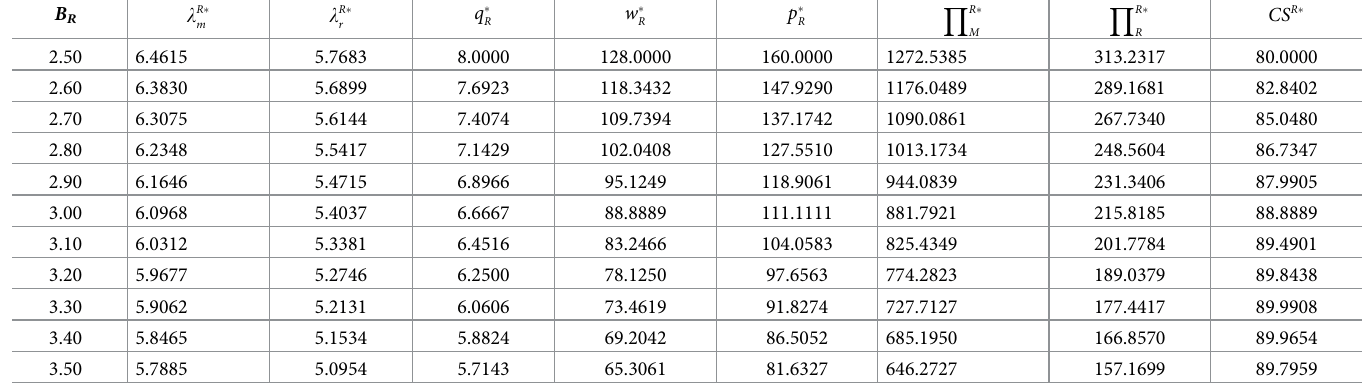
Table 2. In the retail channel scenario.